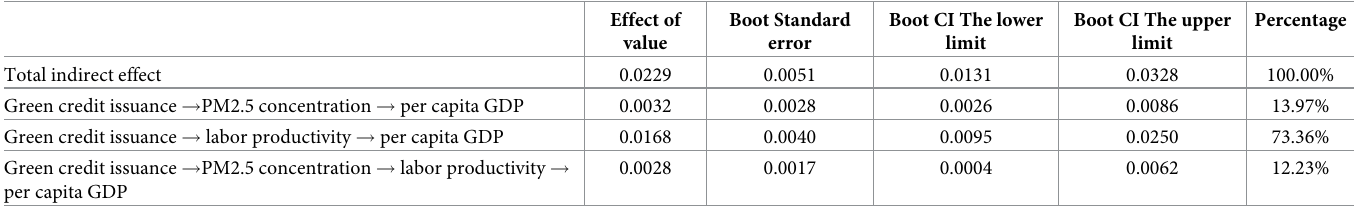
Table 9. Bootstrap sampling test for the mediating effect of labor productivity.